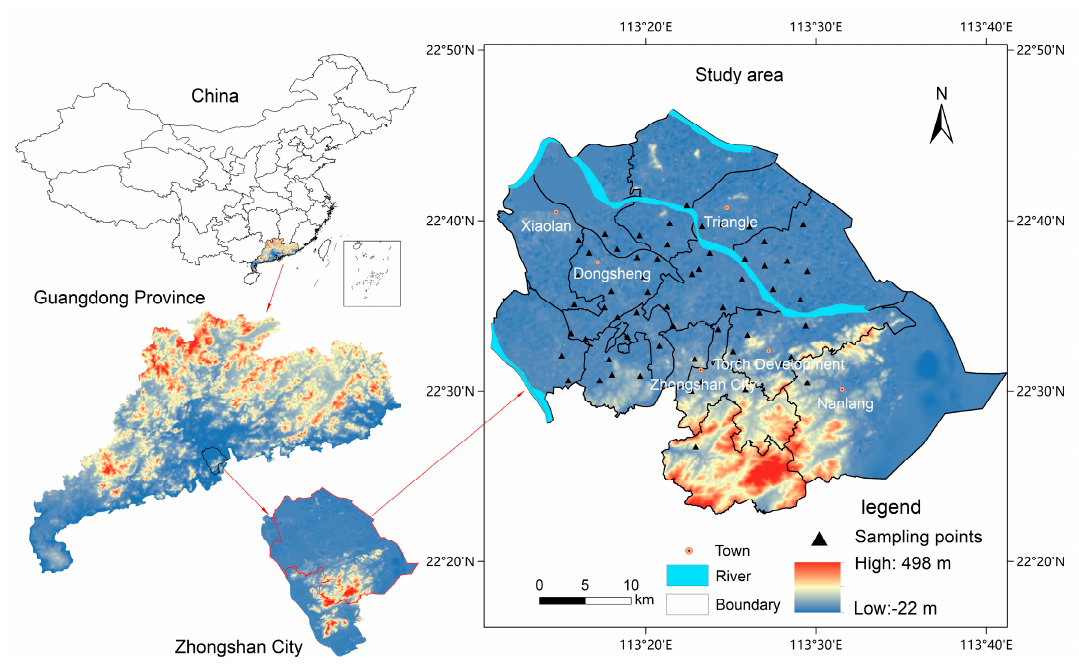
Figure 1. Location of Zhongshan City and soil sample collection sites.